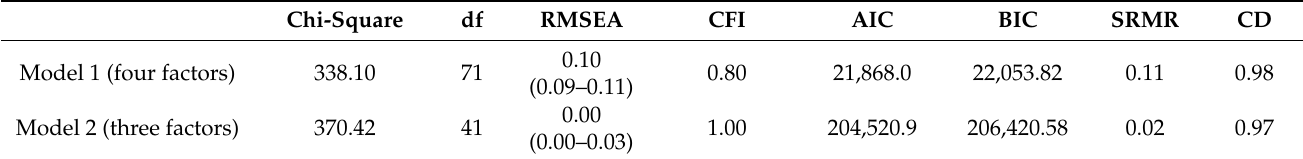
Table 5. Structural equation models fitting í ndices.